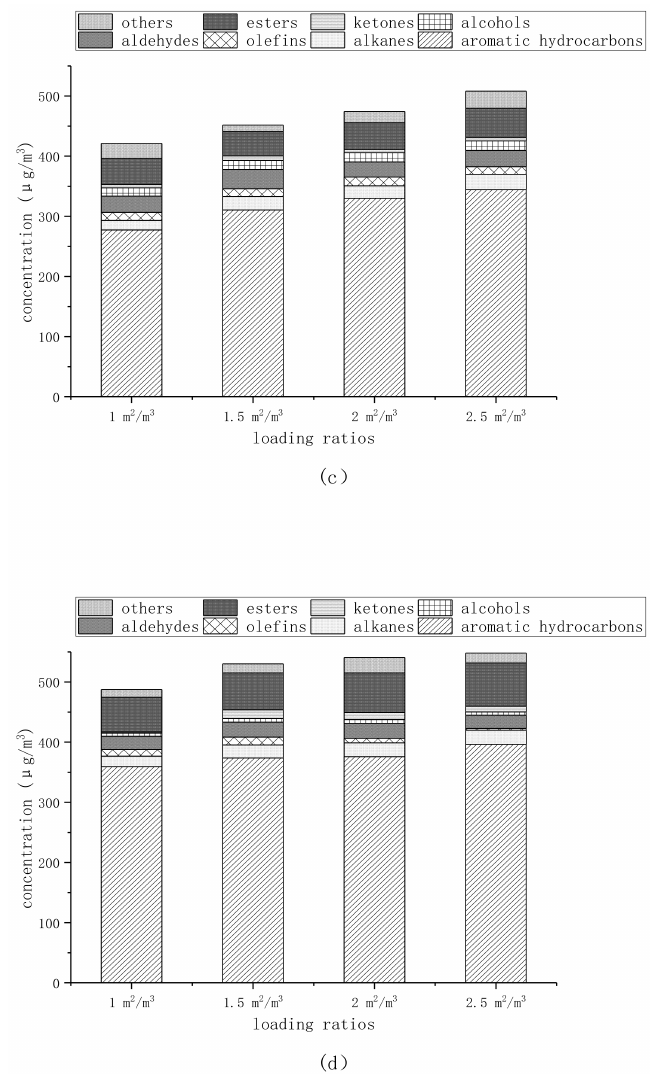
Figure 4. The VOC-components released from PVC-P ( a ), MI-P ( b ), UF-P ( c ) and WP-P ( d ) at 30